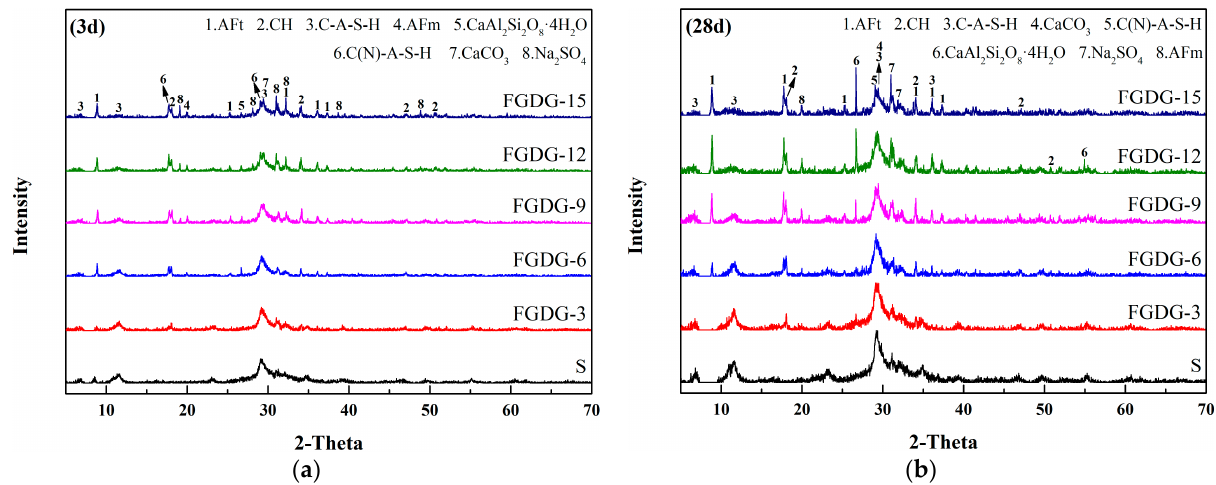
Figure 9. XRD patterns of cement paste with different FGDG content: ( a ) 3 days; ( b ) 28 days.